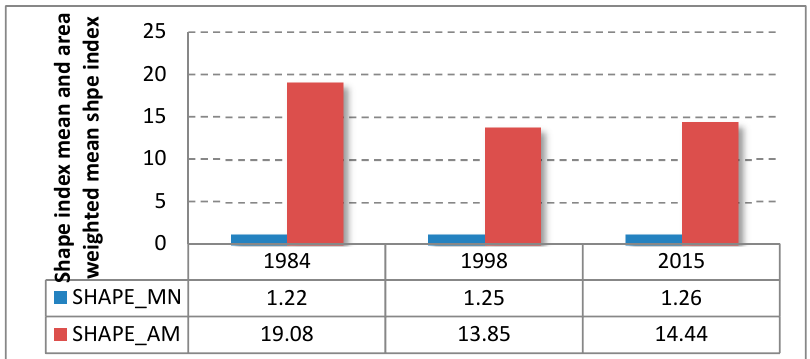
Figure 10. SHAPE_MN and SHAPE_AM for land use and land cover (LULC) changes of the HSCZ 1984, 1998, and 2015.